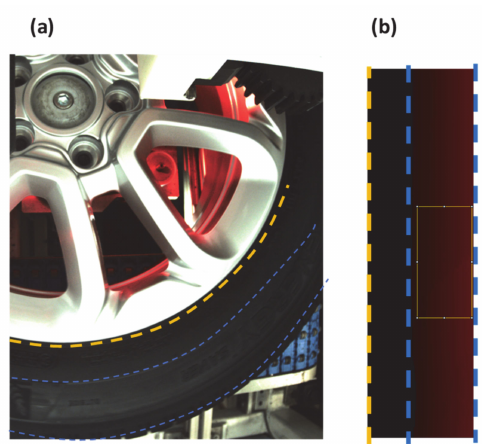
Figure 6. ( a ) Tire positioned on the rotary encoder and areas detected by the camera; ( b ) part of the raw linearized image of the tire sidewall containing assembly defect.